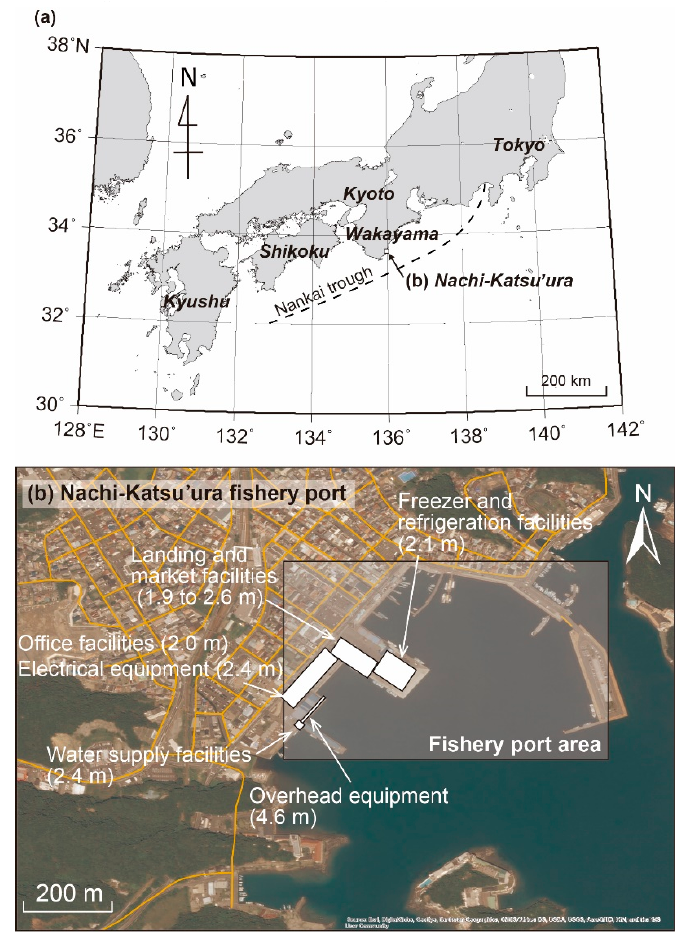
Figure 5. Location ( a ) and elevations ( b ) of fishery facilities and equipment for the Nachi-Katsu’ura Fishery Port of Wakayama Prefecture. The spatial distribution of fishery facilities and equipment in (b) is shown with respect to ground height. Numerals in parentheses indicate the ground height relative to mean sea level in Tokyo